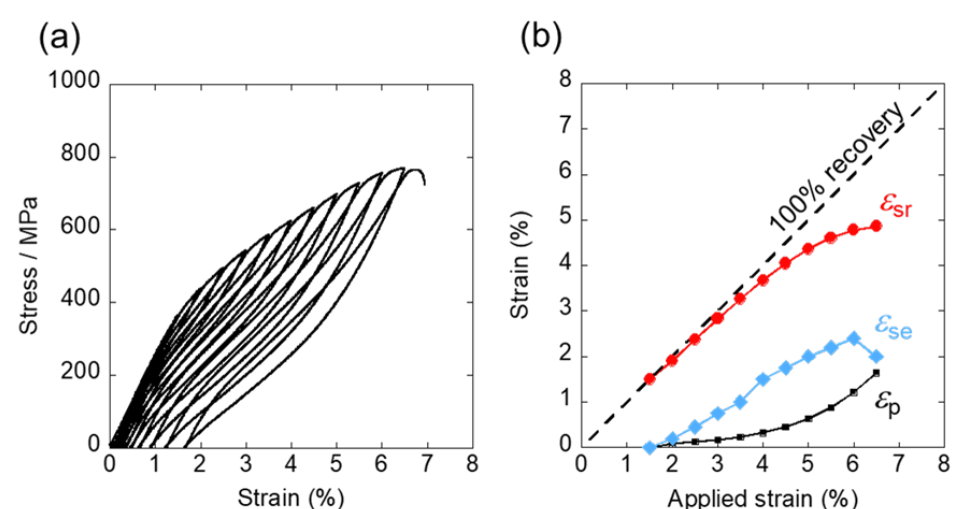
Figure 4. ( a ) Stress-strain curves of 10Al obtained from the cyclic loading-unloading tensile test. ( b ) Plot of various strains (overall shape recovery strain ( ε sr ), transformation strain of superelasticity ( ε se ), and residual plastic strain ( ε p )) as a function of applied strain.